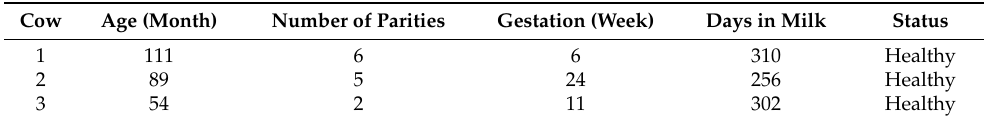
Table 1. Health status of cows used in this